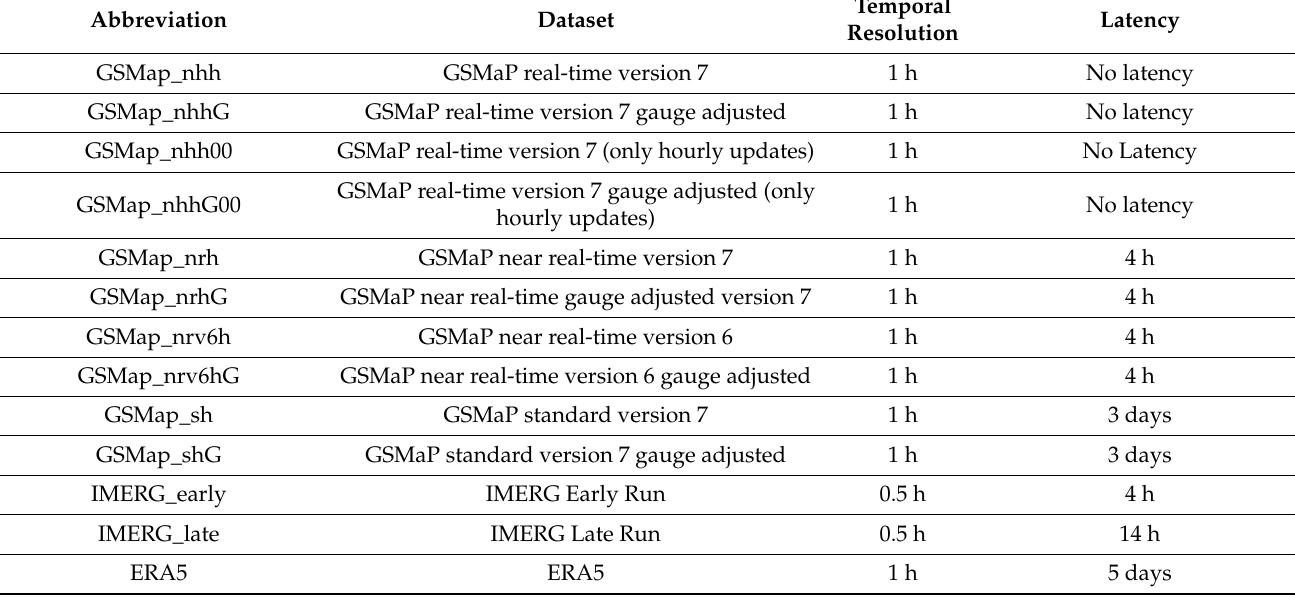
Table 1. Details of different precipitation datasets, which have been analyzed against